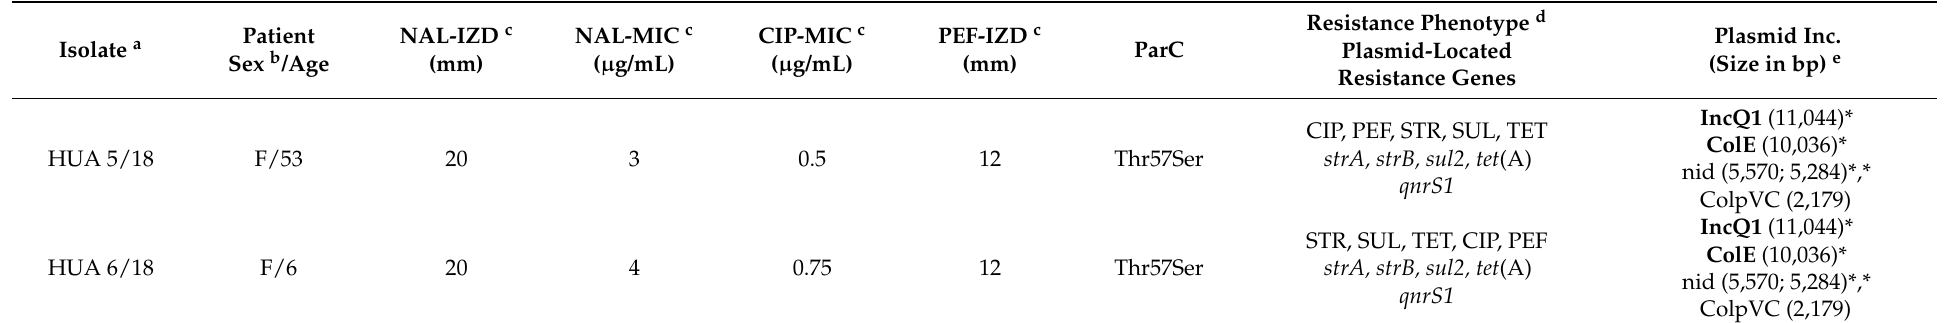
Table 2. Origin, resistance properties and plasmid content of Salmonella enterica serovar Corvallis